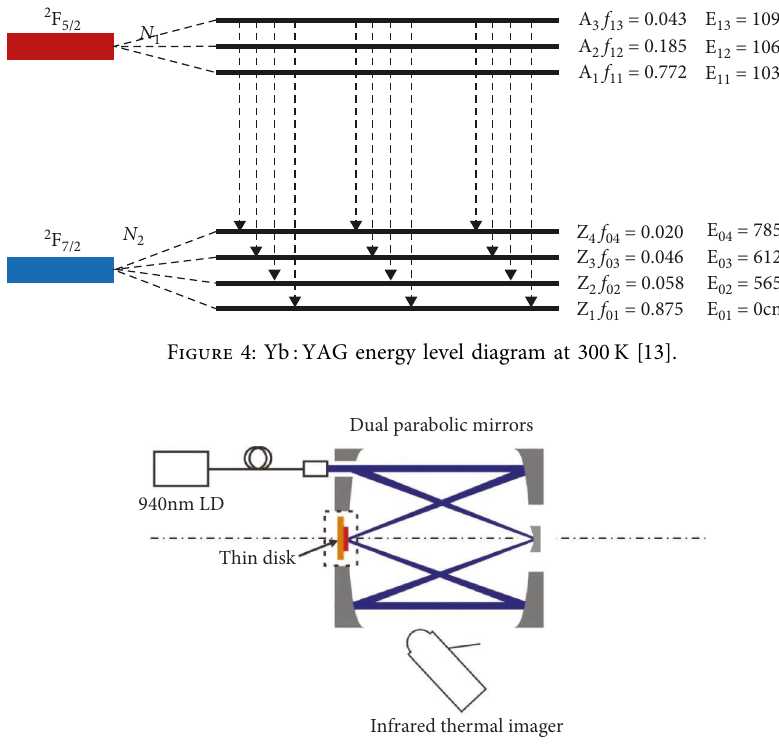
Figure 5: The experimental setup for measuring the temperature of the thin disk